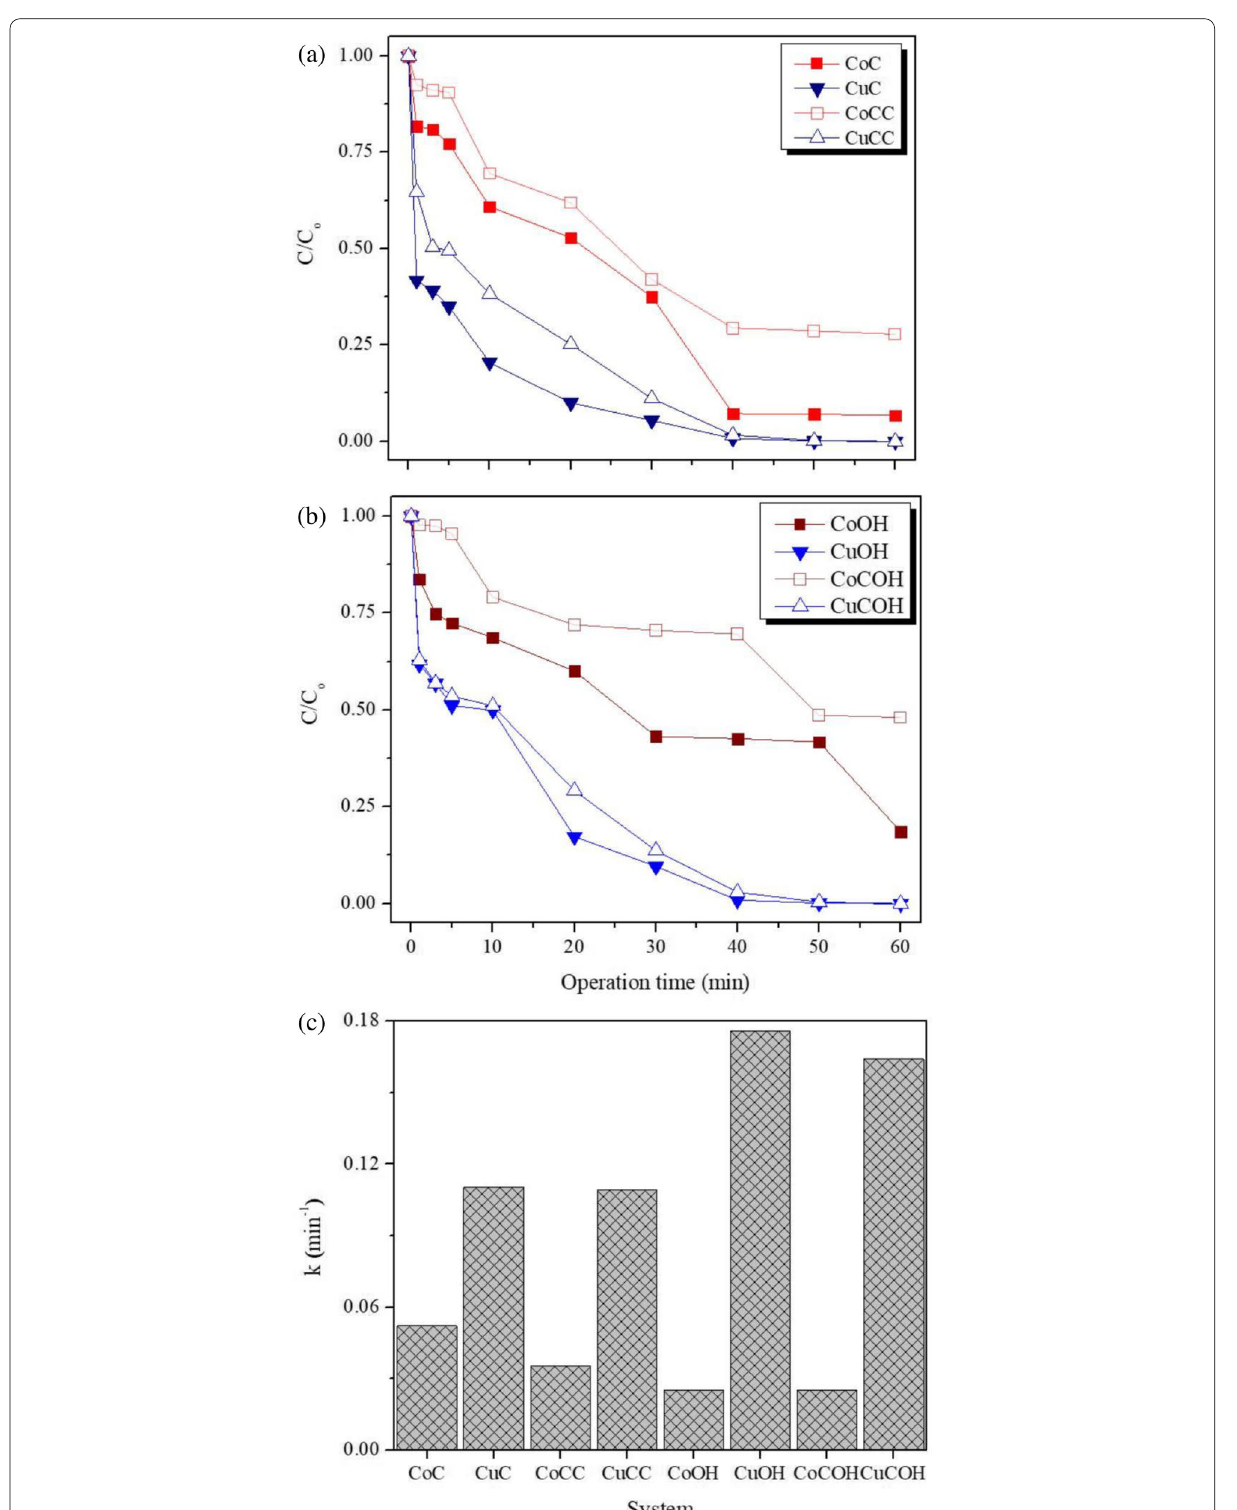
Fig. 14 ( a , b ) Removal of cobalt and copper and ( c ) kinetic rate constant for both precipitant